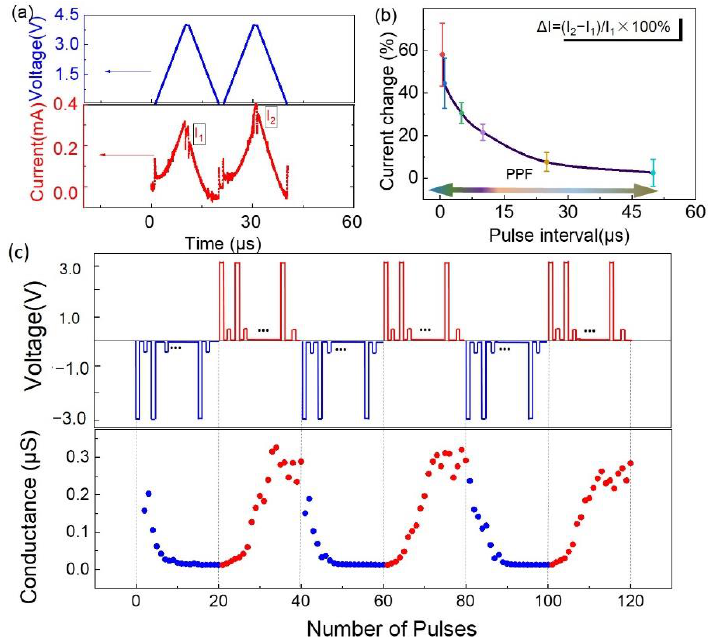
Figure 6. Paired-pulse facilitation (PPF) implementations of the NP-embedded devices with tunable conductance to emulate potentiation (red) and depression (blue); ( a ) excitatory postsynaptic currents (EPSC) in red with their amplitudes of I 1 and I 2 stimulated by a pair of presynaptic voltage spikes (blue); ( b ) current change, defined as (I 2 − I 1 )/I 1 × 100%, plotted as a function of pulse interval times; ( c ) gradual conductance modulation for the devices under pulse stimulation is shown on the top.